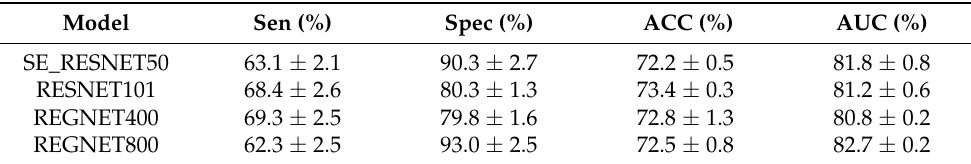
Table 4. Performance of four types of self-supervised pre-trained models without mixed loss strategy and sample reweighting methods in the validation cohort.